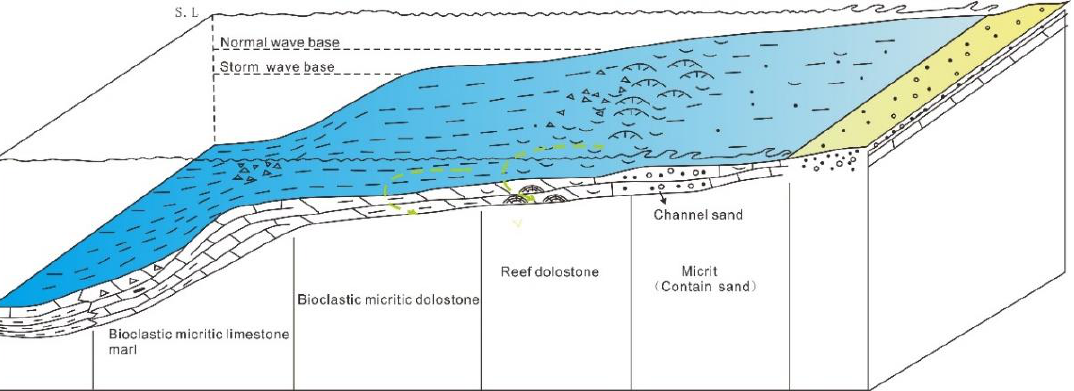
Figure 9. The deposition and proposed dolomitization process of D 2 g in the northwestern Sichuan Basin. The sedimentary facies mainly consisted of tidal flats, platforms, and restricted sea, and the GWSF developed algal limestone (reef dolostone) and bioclastic limestone (dolomite).